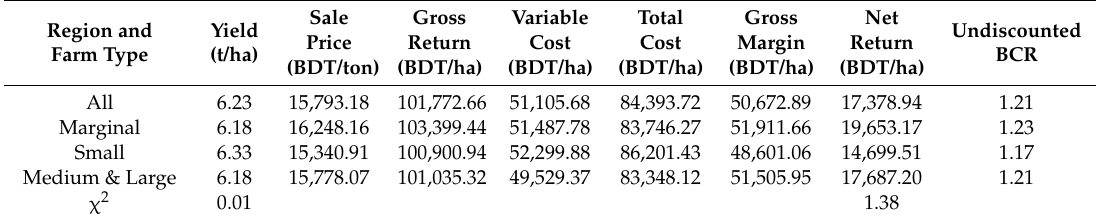
Table 4. Financial profitability of HYV winter Maize according to farm size in northwestern